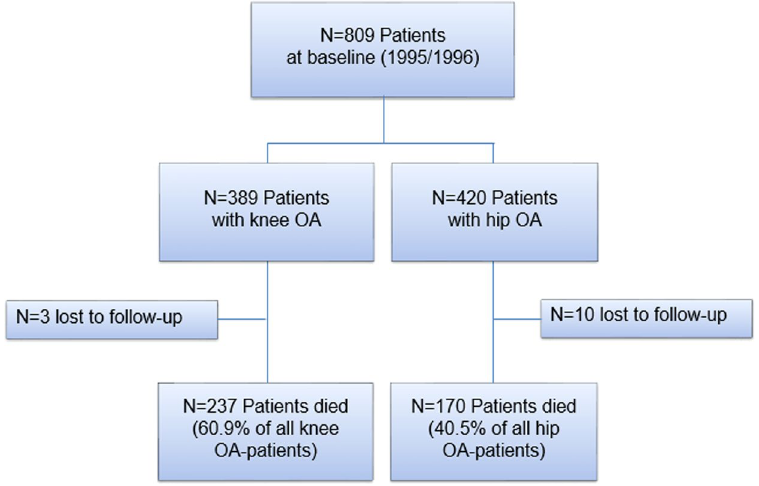
Figure 1. Patients flow chart and mortality during 20 years of follow-up. OA osteoarthritis, N number of